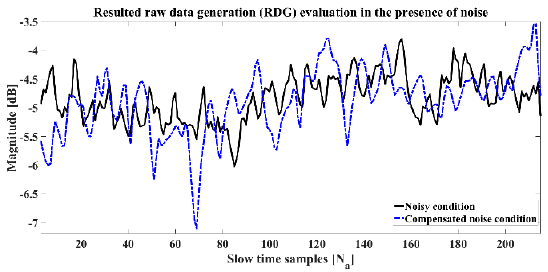
Figure 9. Reference RDG evaluation in the presence of noise and compensated noise conditions.